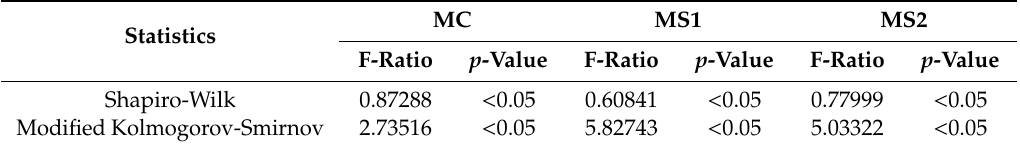
Figure 5. Tukey’s honestly significant di ff erence (HDS) plot for PSD by optical microscopy. Table 3. Analysis of normal distribution for samples analyzed by optical microscopy and laser di ff raction technique.